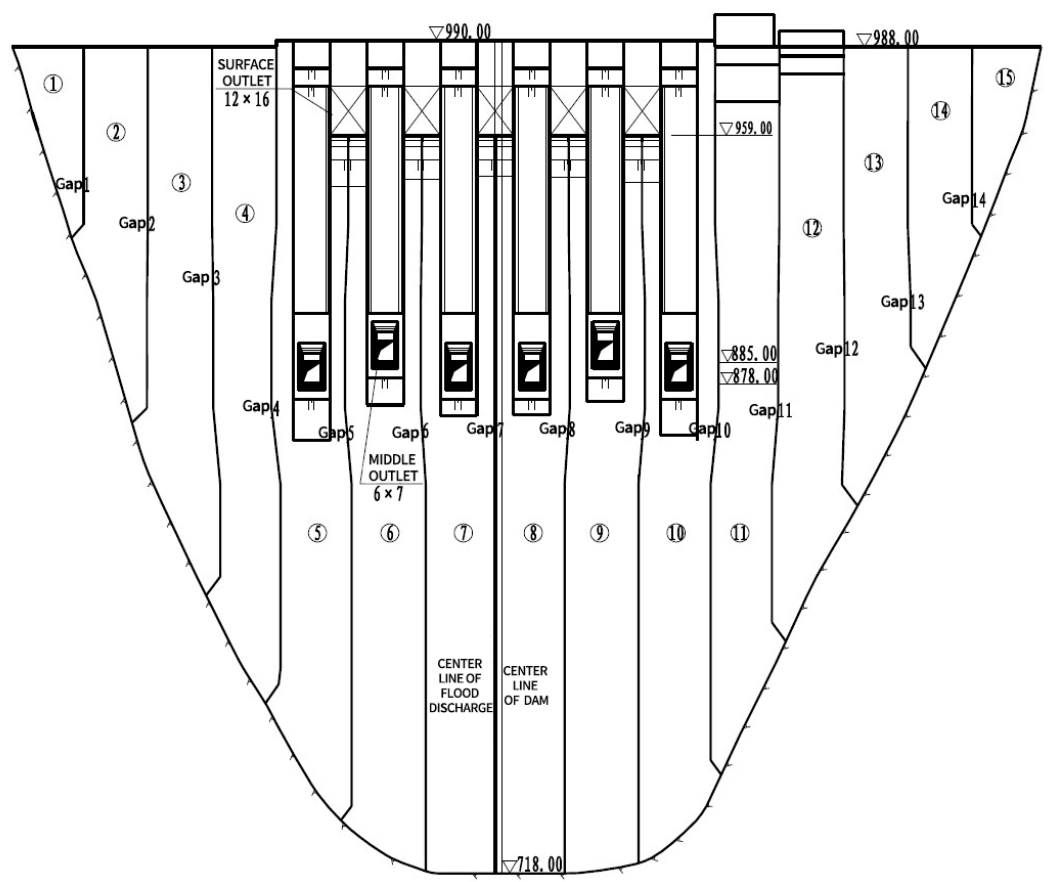
Figure 2. Schematic diagram of dam body structure.